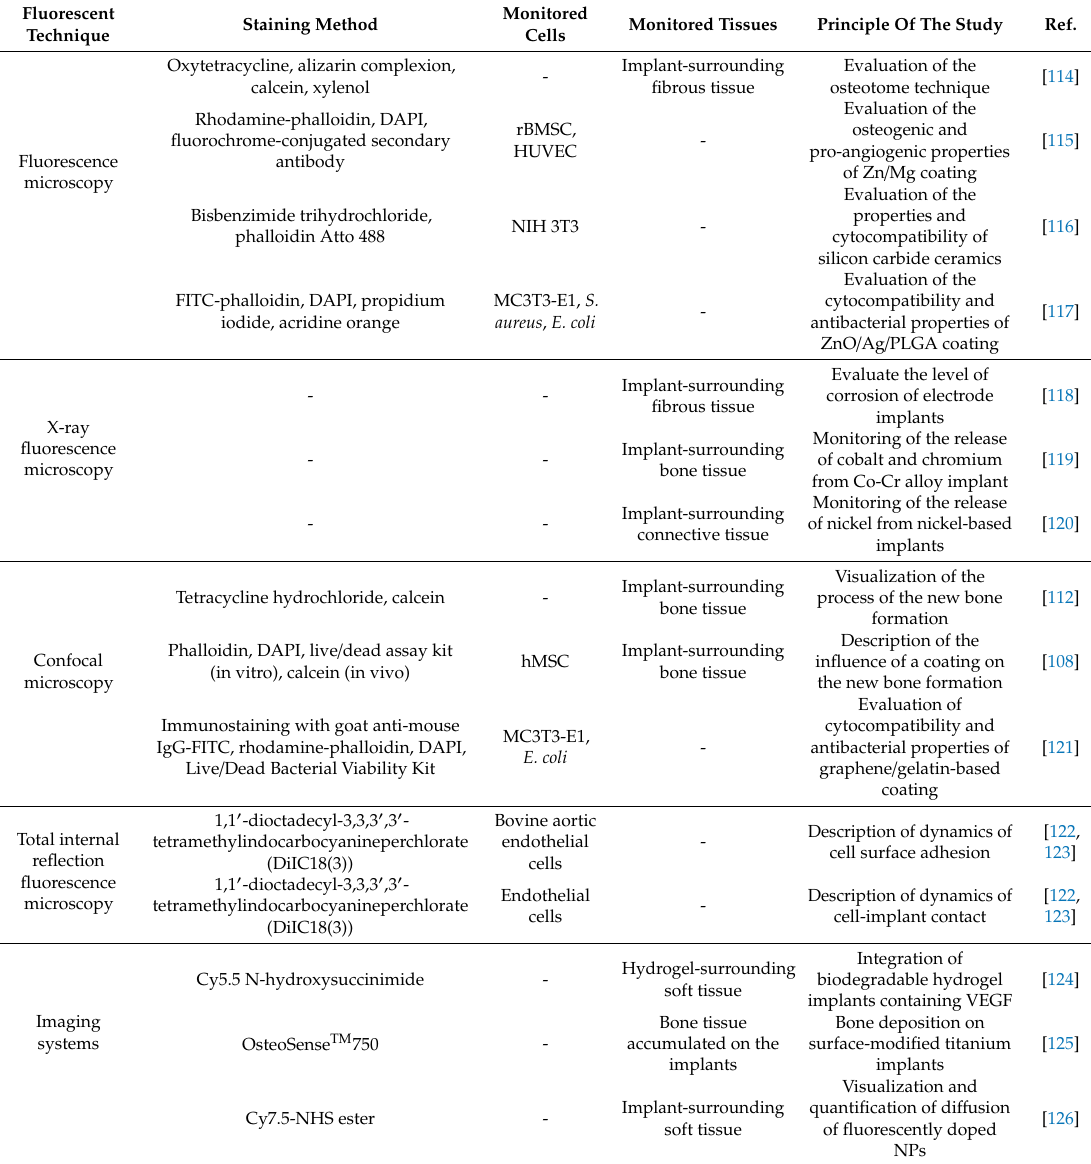
Table 3. Summary of the fluorescence techniques and their applications in biomaterial studies and